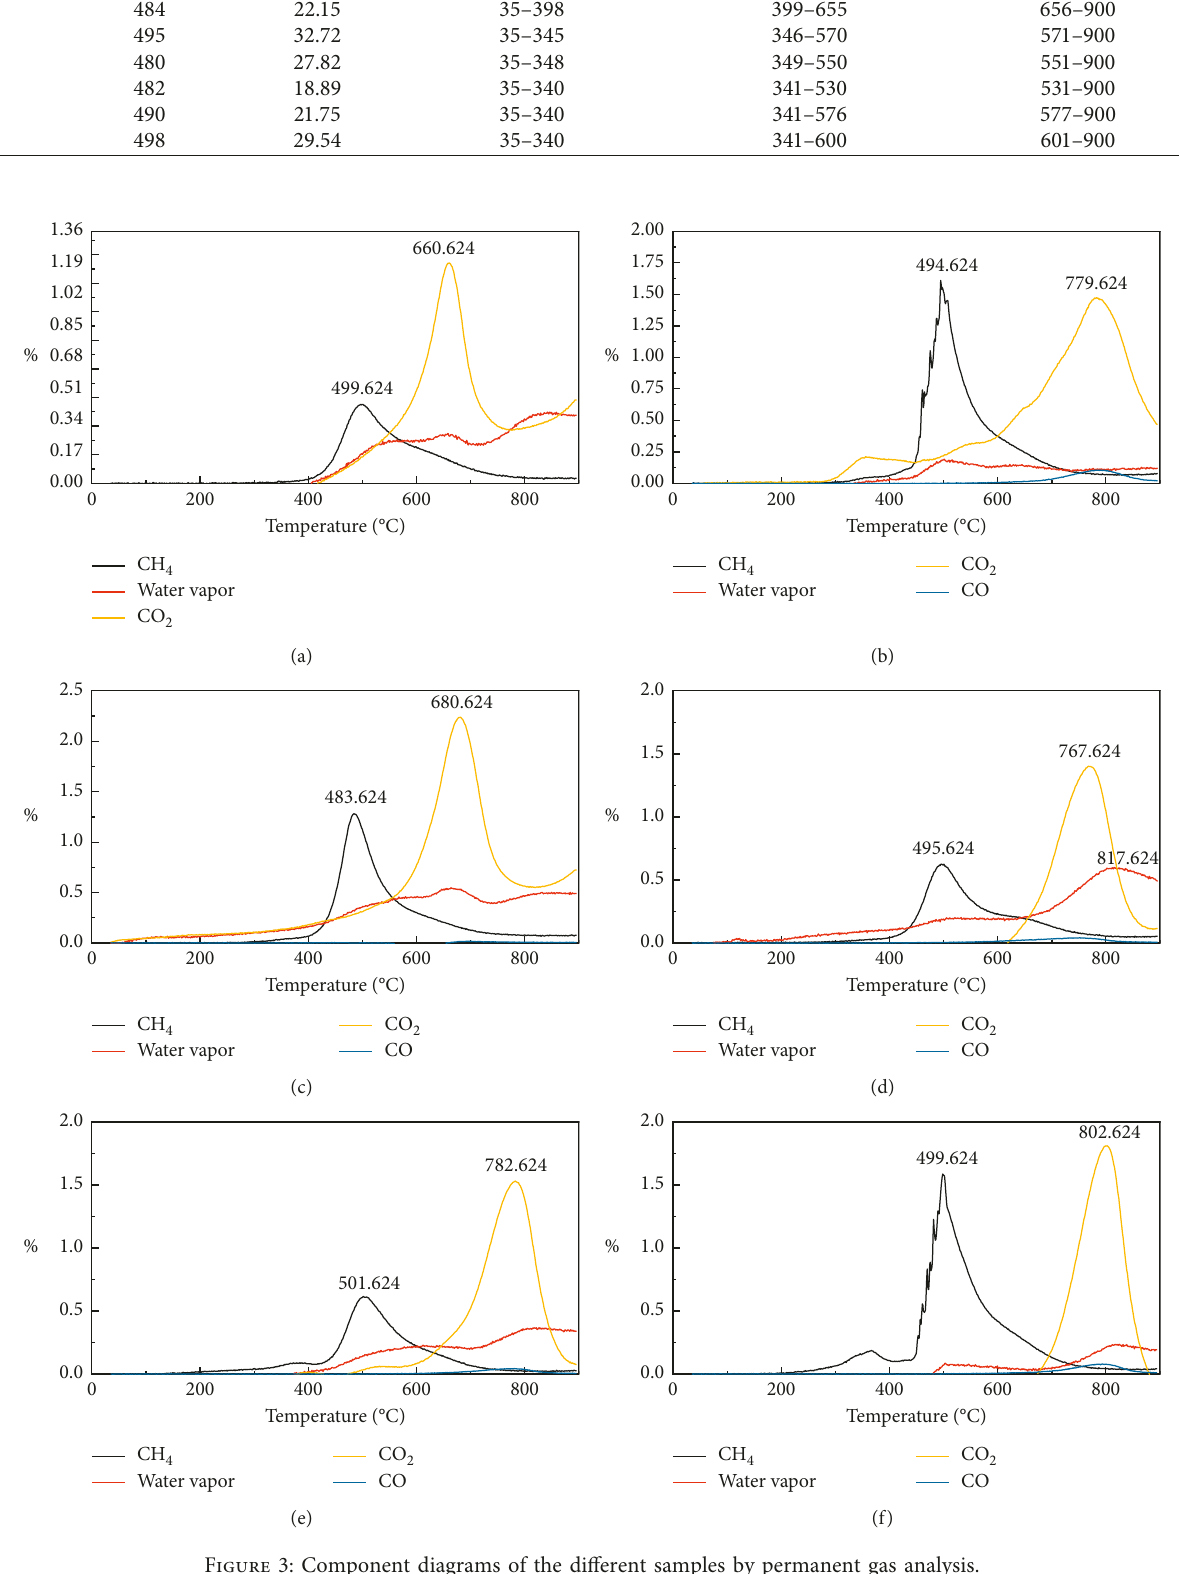
Figure 3: Component diagrams of the different samples by permanent gas